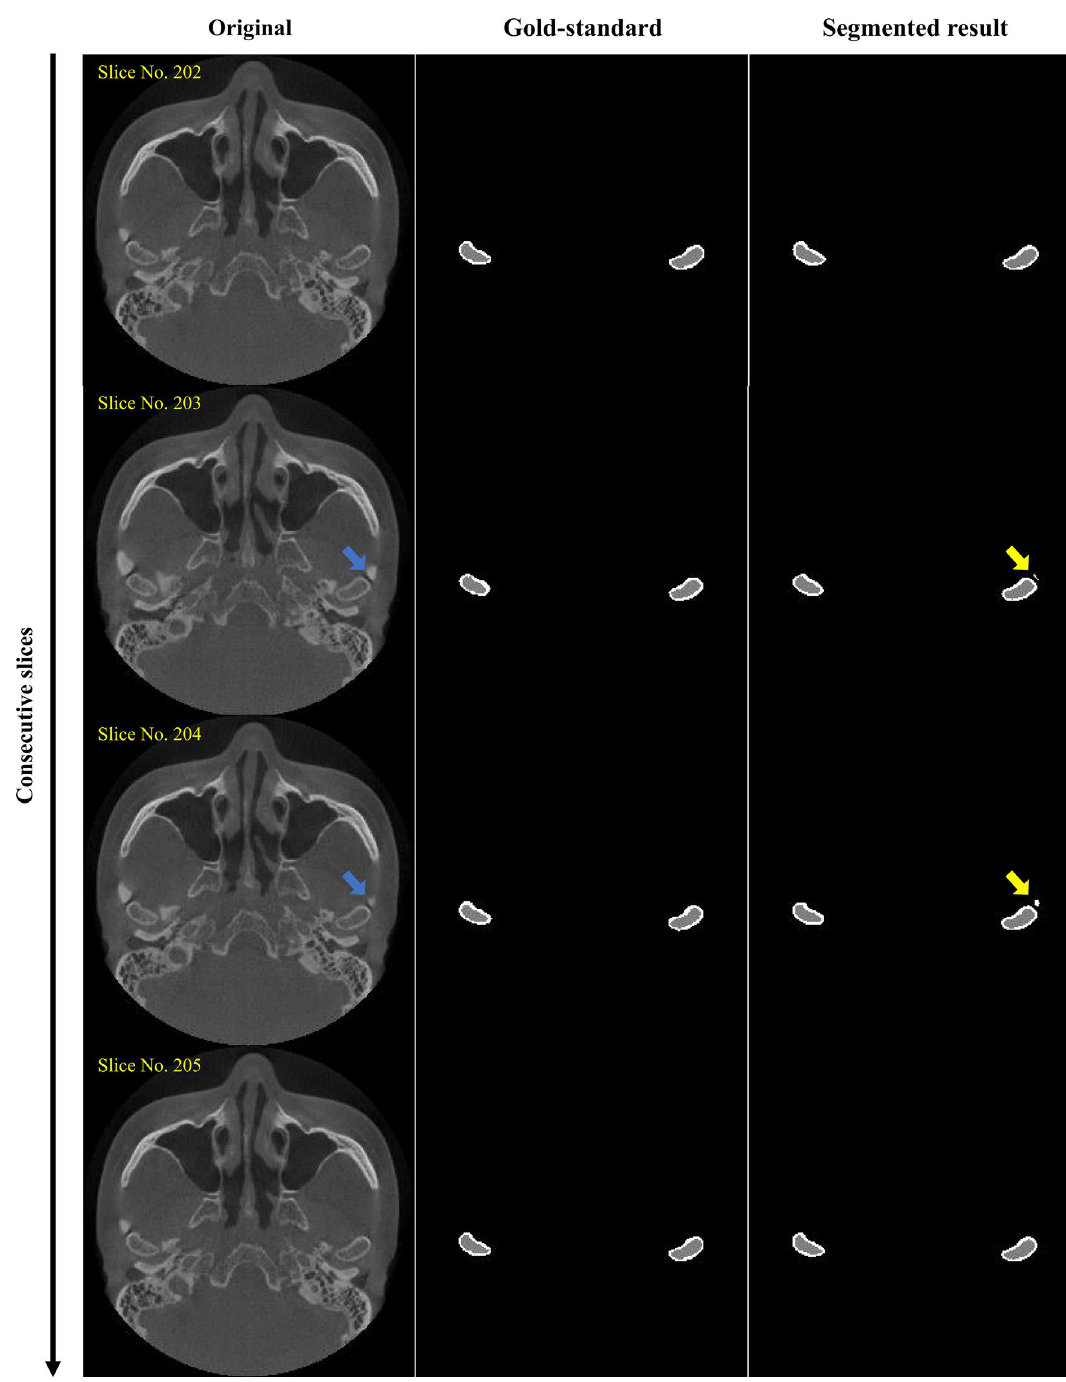
Figure 5. Examples of poorly segmented results obtained from the proposed segmentation model. From the consecutive slices, two poorly segmented slices were observed. The blue arrows indicate the surrounding anatomical structure of the condyle head, and the yellow arrows indicate the mis-segmented